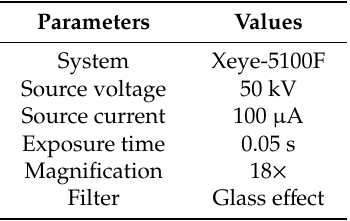
Figure 2. Illustration of the working procedure to develop the classification model for watermelon seed quality based on their morphological patterns. Table 1. Image acquisition parameters for X-ray projection imaging.